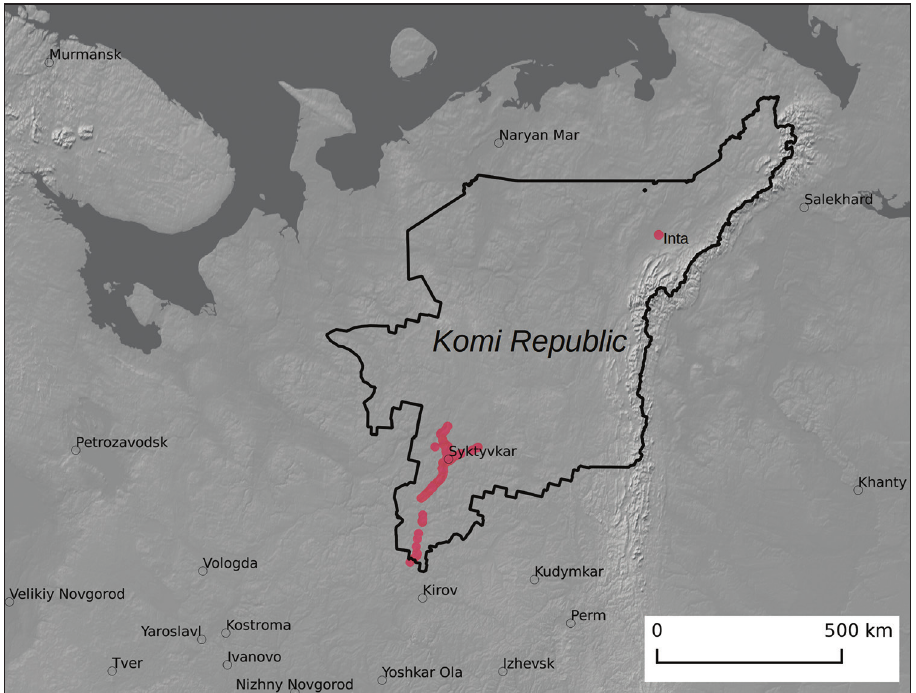
Figure 1. Study area. Red points indicate occurrences of Heracleum sosnowskyi described in the data